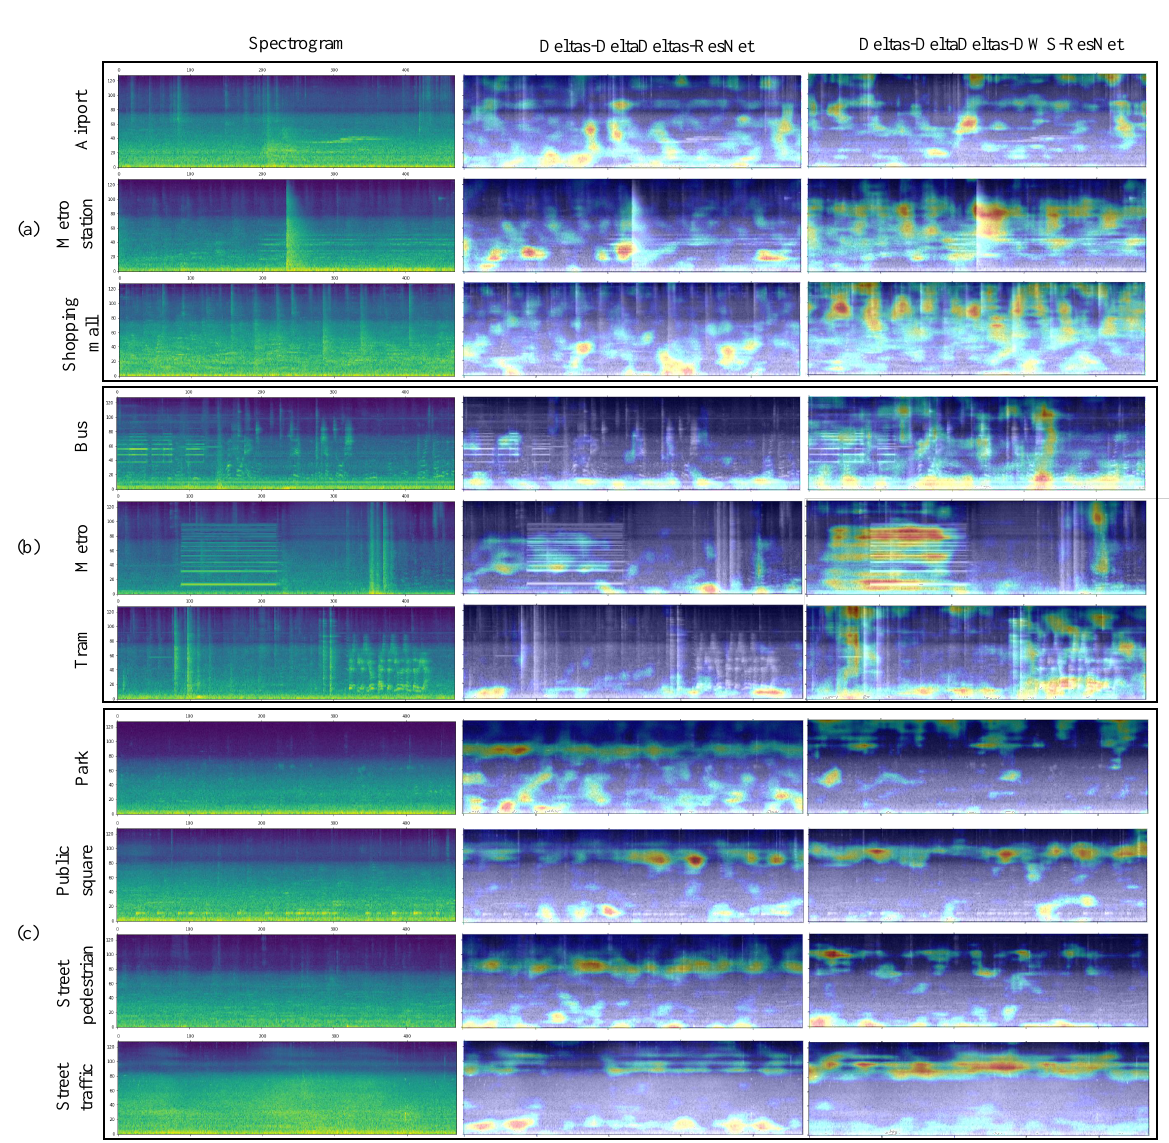
Figure 6. Grad-CAM results: ( a ) indoor, ( b ) transportation, and ( c )